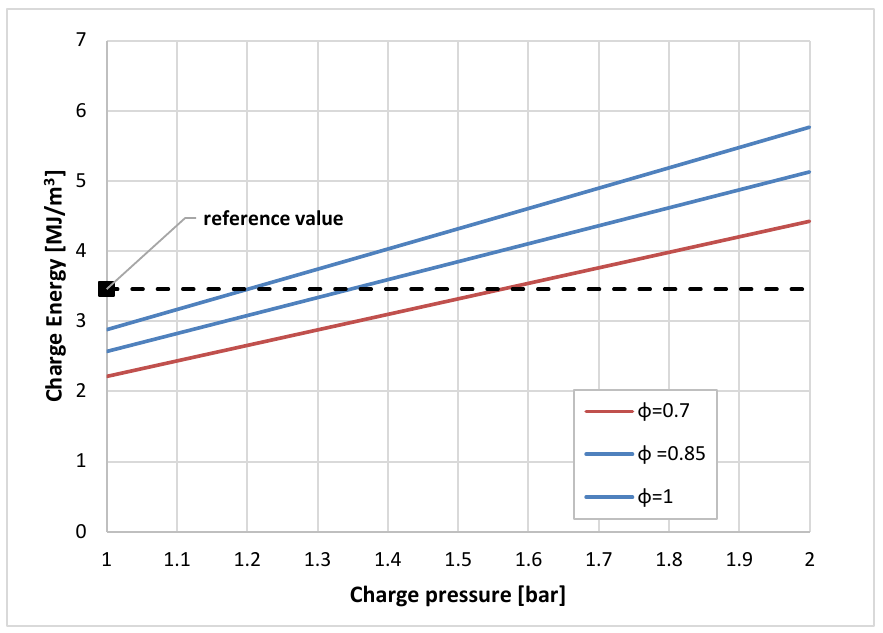
Figure 1. Heat released by a volume unit of air – H 2 mixtures at T = 25 °C and different pressures. Reference value is the heat released by a volume unit of a stoichiometric air-gasoline mixture at the same temperature and a pressure equal to 1 Bar.